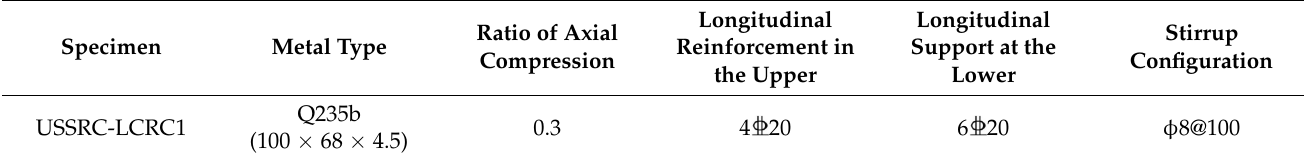
Figure 8. Dimensions and reinforcement of USSRC-LCRC1 specimens.